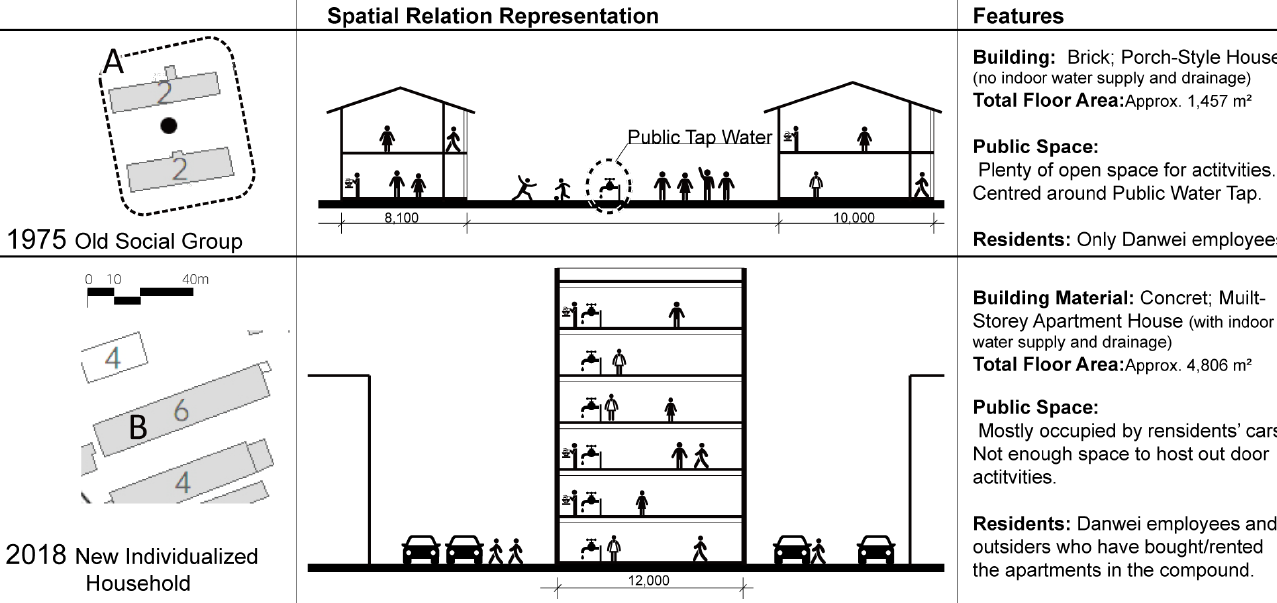
Figure 13. Living environment conditions. (A, B represent the building and public space marked by A, B in Figure